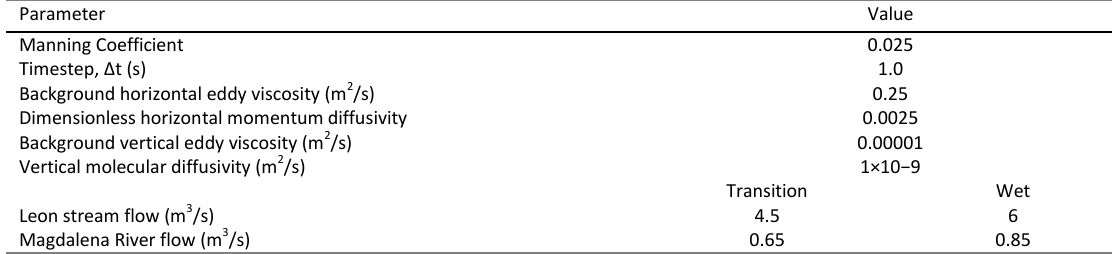
Table 3: Input data and key parameters for hydrodynamic module.